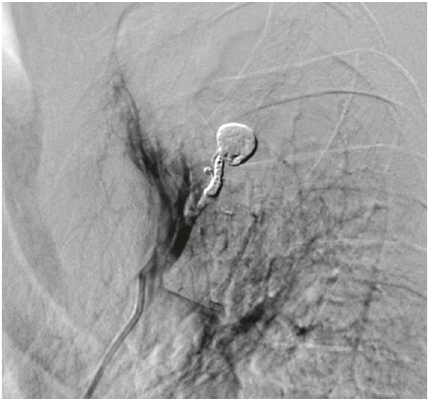
Figure 7: Non-contrast-enhanced axial computed tomography image. Two months after the treatment, the aneurysm is filled with the mixture of n-butyl-2-cyanoacrylate and iodized oil